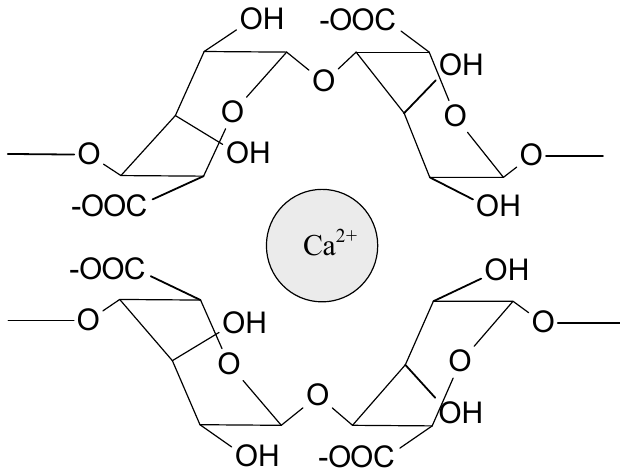
Figure 3. Schematic representation of the ionic interaction of calcium ion with alginate.